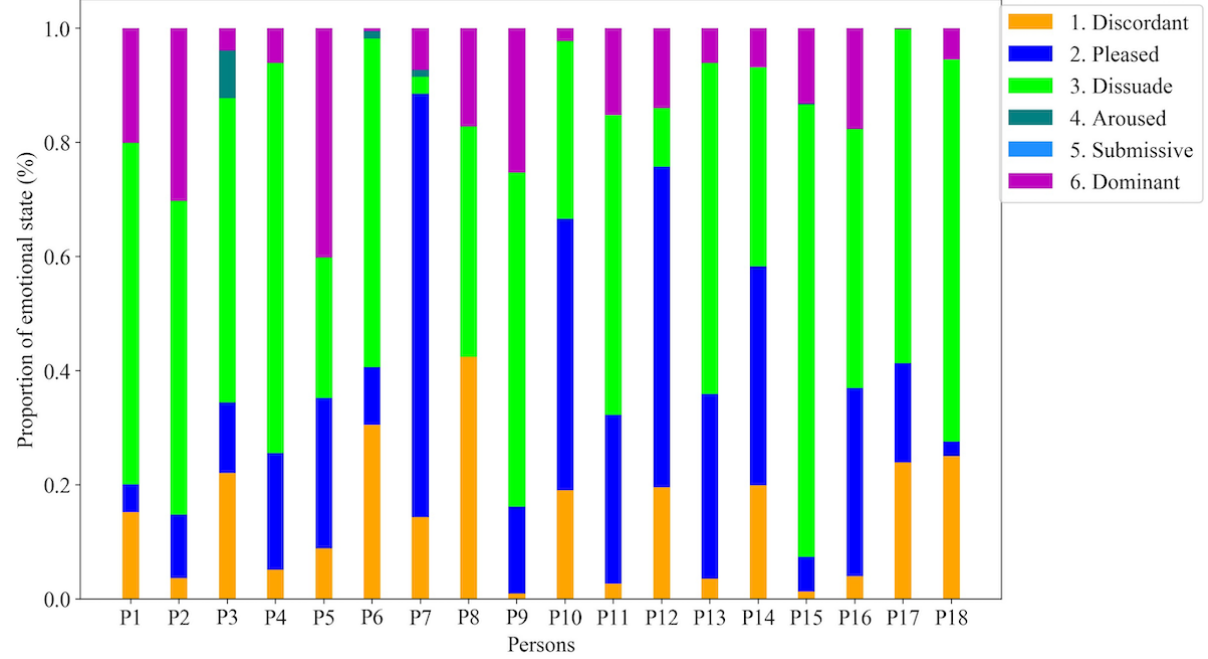
Figure 1. Proportion (%) of 6 emotional states per person. Pleased and dissuaded are the most frequent, whereas submissive and aroused are the least frequent emotional states among the 18 persons in our data